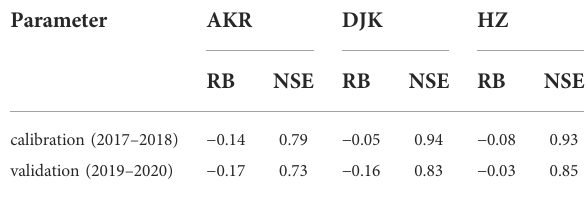
TABLE 2 Index evaluation results of each